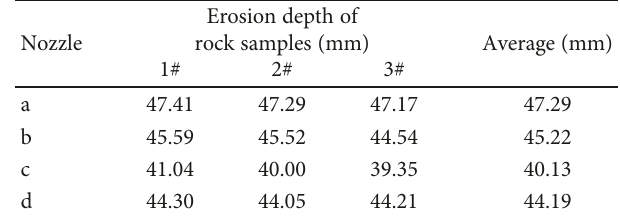
Figure 12: Connection schematic of high-pressure abrasive air jet erosion system.